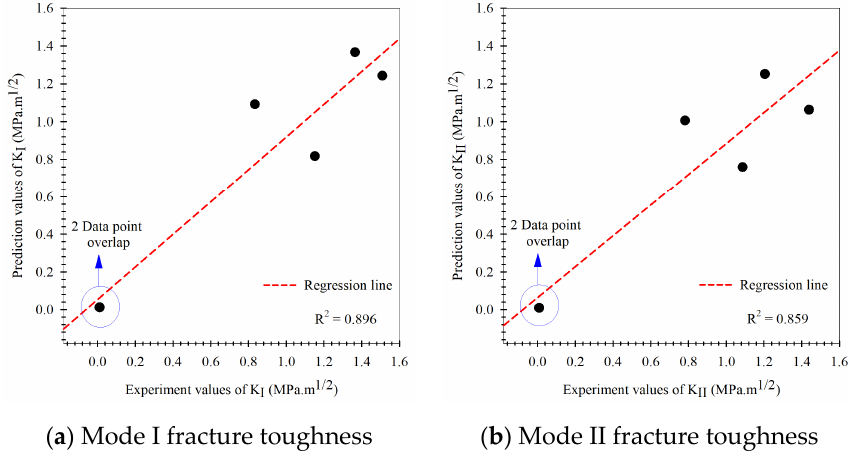
Figure 9. Prediction results of the original Kriging model compared to the experiment results.